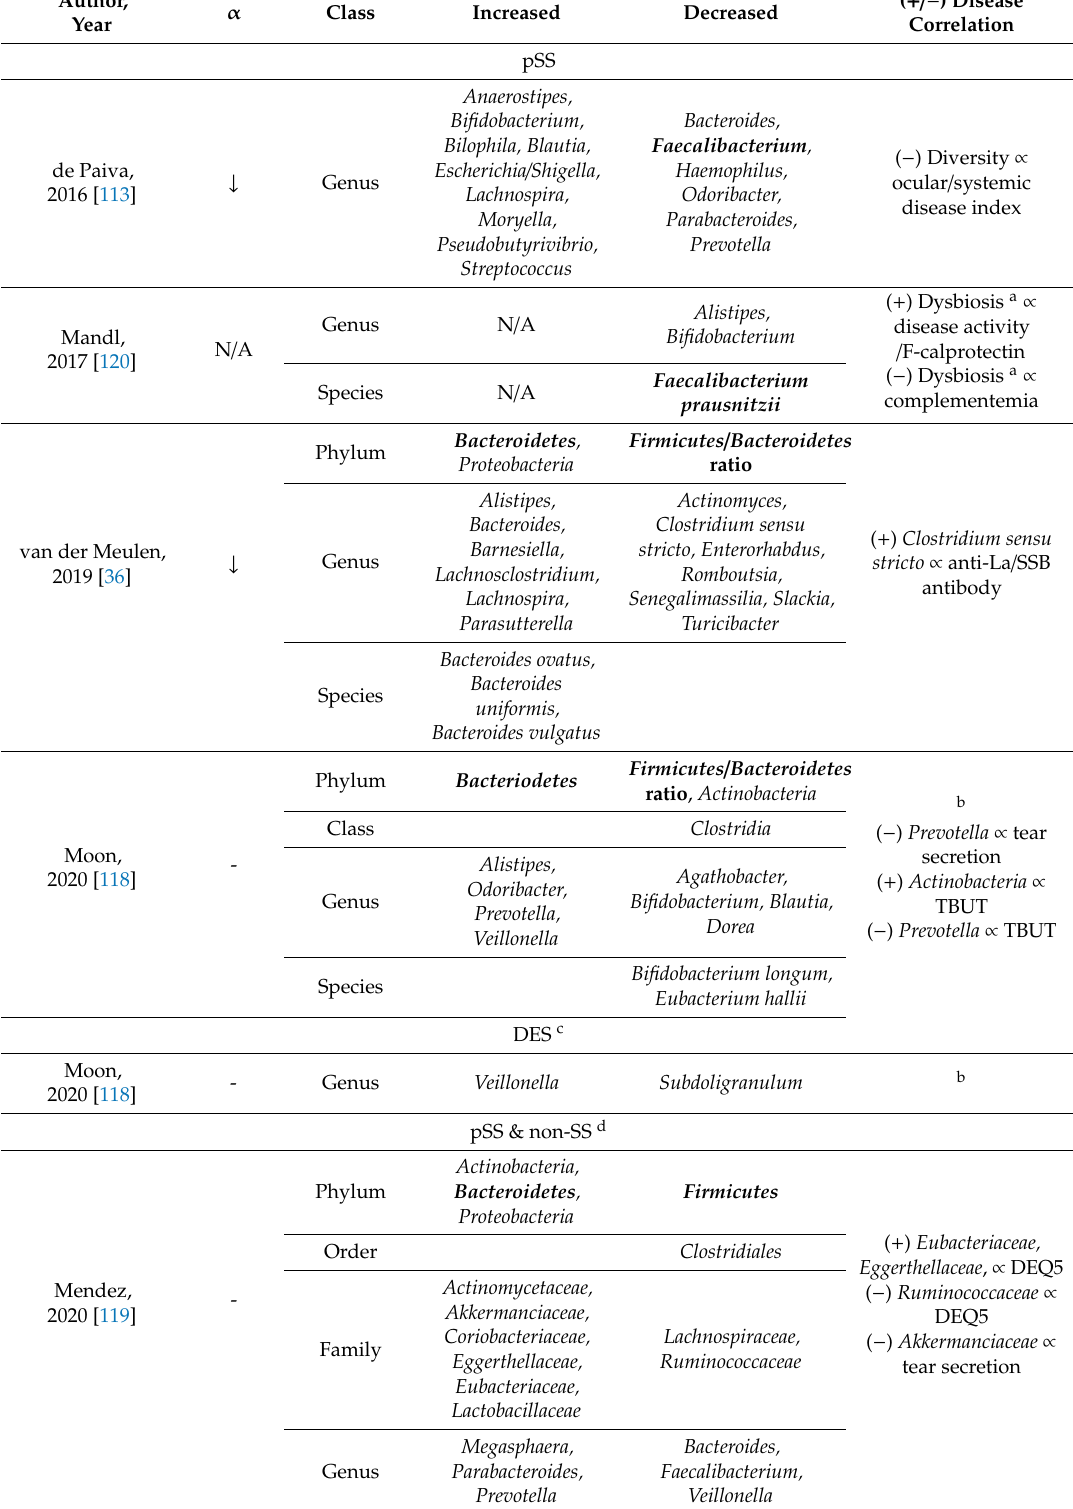
Table 5. Human studies of dry eye-related representative gut